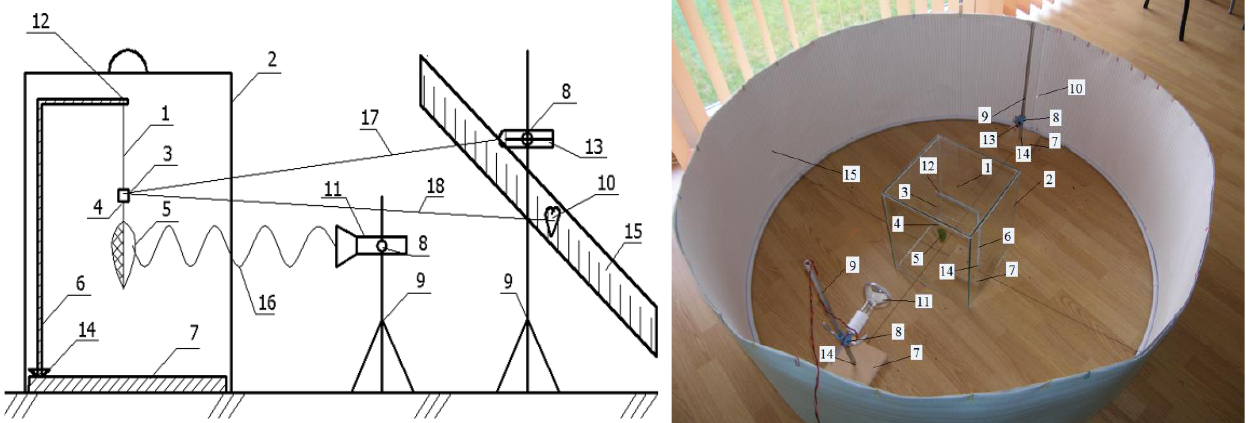
Figure 3. Line diagram of experimental stand to test heat conversion in a plant leaf: 1 — metal filament to suspend the leaf; 2 — transparent hood; 3 — beam reflection mirror; 4 — leaf holding mechanisms; 5 — test item; 6 — test item retaining rack; 7 — stand foot; 8 — height control handle; 9 — stands; 10 — specular reflection (laser point); 11 — illumination source; 12 — suspended leaf height adjustment mechanism; 13 — mirror illumination laser; 14 — stand fixing mechanisms; 15 — motion monitoring ruler; 16 — light source device; 17 — laser beam; 18 — laser beam reflecting from the mirror.